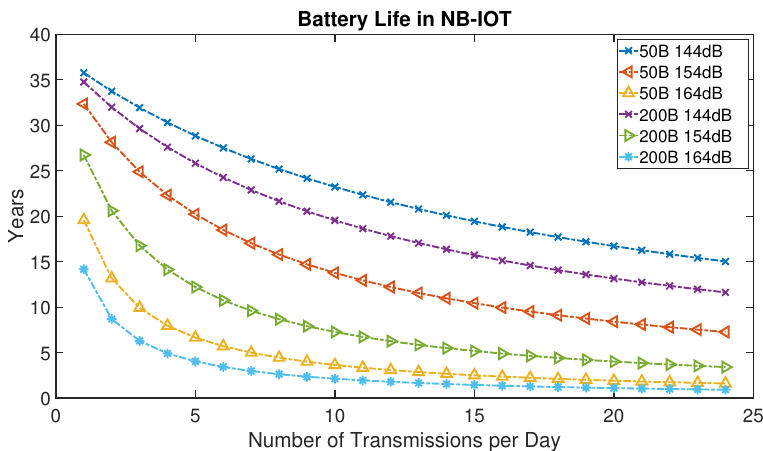
Figure 7. NB-IoT battery lifetime analysis for short data packets of 50 bytes (B) and 200 bytes (B) for Different